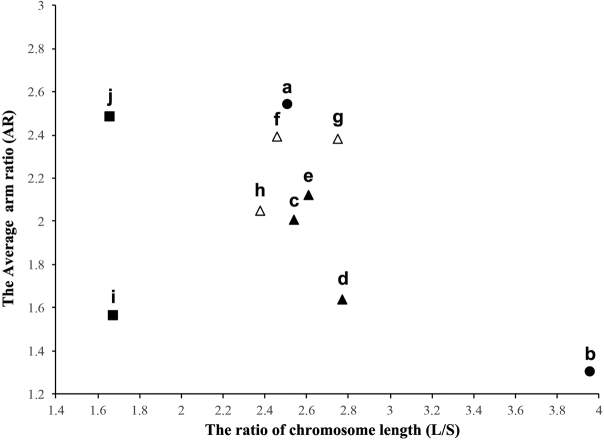
The karyotype asymmetry plot of echiurans, sipunculids and several annelids. a echiuran, U.unicinctusb echiuran, A.maculatac annelid, N.oligohalinad annelid, P.anderssonie annelid, H.diversicolorf annelid, D.ghilarovig annelid, E.balatonicah annelid, A.caliginosai sipunculid, S.nudusj sipunculids, P.esculenta. symbols: circle, echiurans; square, sipunculids; triangle, polychaeta; hollow triangle, oligochaeta.